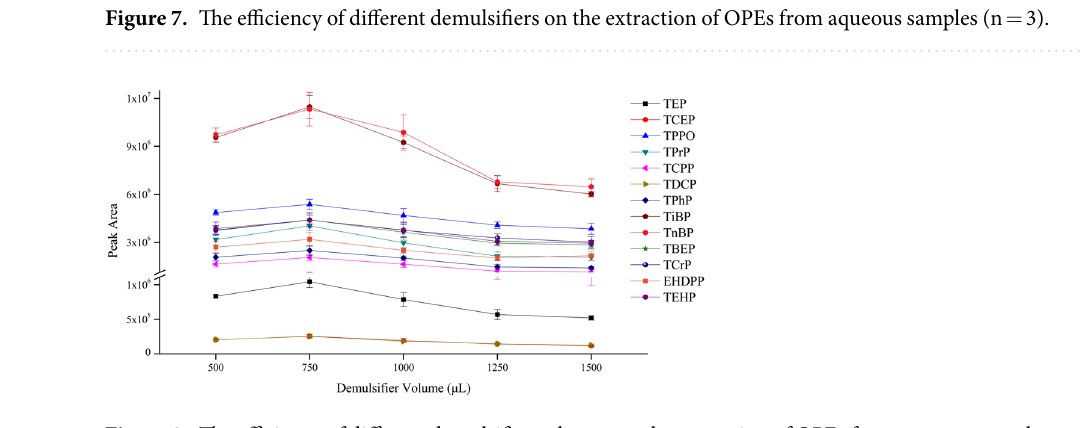
Figure 8. The efficiency of different demulsifier volumes on the extraction of OPEs from aqueous samples (n = 3).